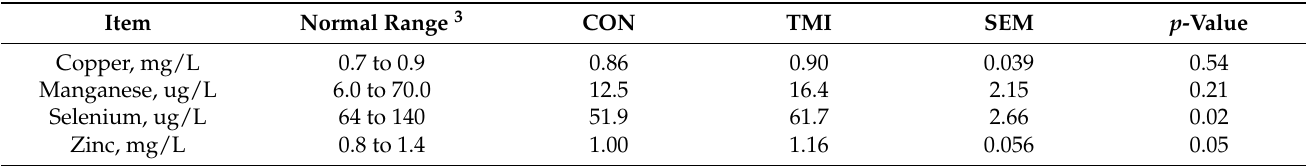
Table 4. Effect of trace mineral injection (TMI) 1 or no TMI (CON) on calf plasma concentrations 2 at branding (49 ± 1.3 days of age) in year